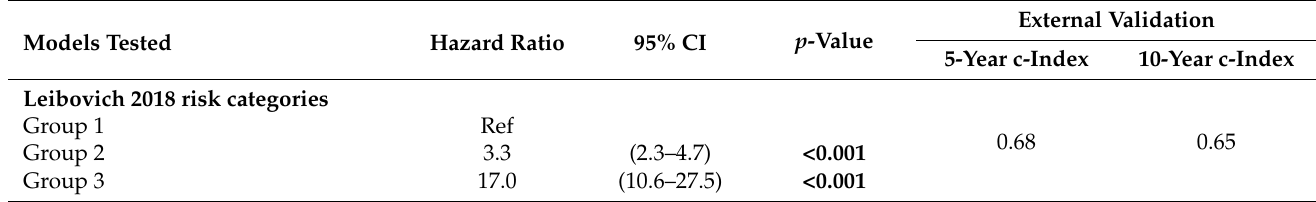
Table 2. Separate univariable Cox regression models predicting cancer-specific mortality according to Leibovich 2018 risk categories and GRANT risk categories. For each model, c-indexes addressing the concordance between predicted and observed survival rates at five and ten years are